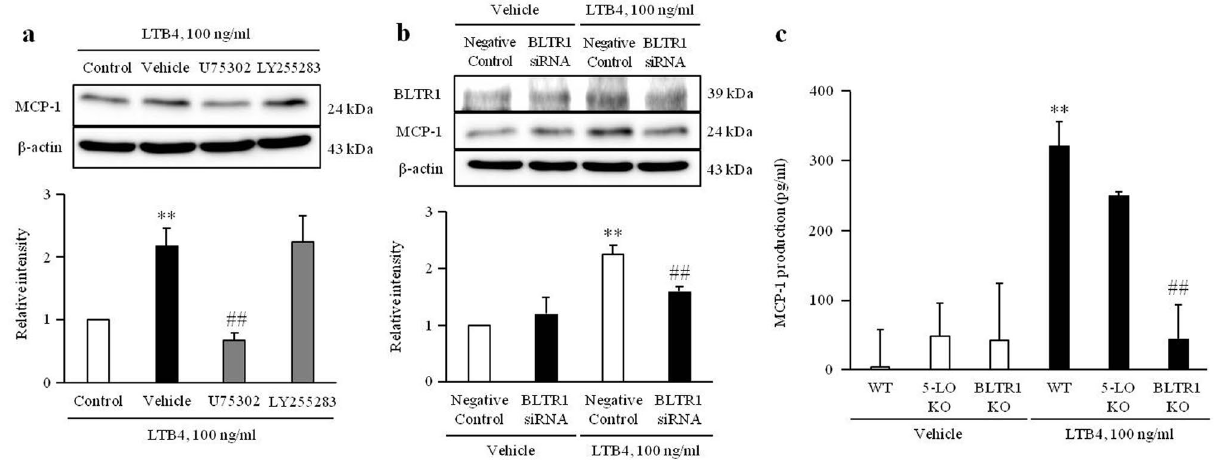
Figure 5. A pivotal role of BLTR1 on LTB4-induced MCP-1 production and expression in VSMCs. ( a ) VSMCs were pretreated with U75302 (10 μM) or LY255283 (10 μM) for 1 h, and then stimulated with LTB4 (100 ng/ ml) for 48 h. The expression levels of MCP-1 were determined by Western blotting using β-actin as an internal control. Results were expressed as the mean ± SEM of 3 independent experiments. ** p < 0.01 vs. value in control and ## p < 0.01 vs value in vehicle. ( b ) VSMCs were transfected with BLTR1 siRNA (200 nM) for 48 h, and then stimulated with LTB4 (100 ng/ml) for 48 h. The expression levels of MCP-1 were determined by Western blotting using β-actin as an internal control. Results were expressed as the mean ± SEM of 4 independent experiments. ** p < 0.01 vs. corresponding negative control in Vehicle and ## p < 0.01 vs negative control in LTB4 group. Image analysis was performed using the Amersham-Imager 680, ver. 2.0. software (https:// www. cytiv alife scien ces. com/). Cropped gels were displayed and full-length blots/gels are presented in supplementary Fig. S5. ( c ) VSMCs cultured from thoracic aorta of WT, 5-LO- and BLTR1-KO mice were treated with LTB4 (100 ng/ ml) for 48 h. MCP-1 production was measured in the cell culture media, and results were expressed as the mean ± SEM of 3 independent experiments. ** p < 0.01 vs. corresponding value in vehicle and ## p < 0.01 vs WT in LTB4 group. Signal was quantified with GraphPad Prism 5, ver. 5.01. software (https:// www. graph pad. com/).